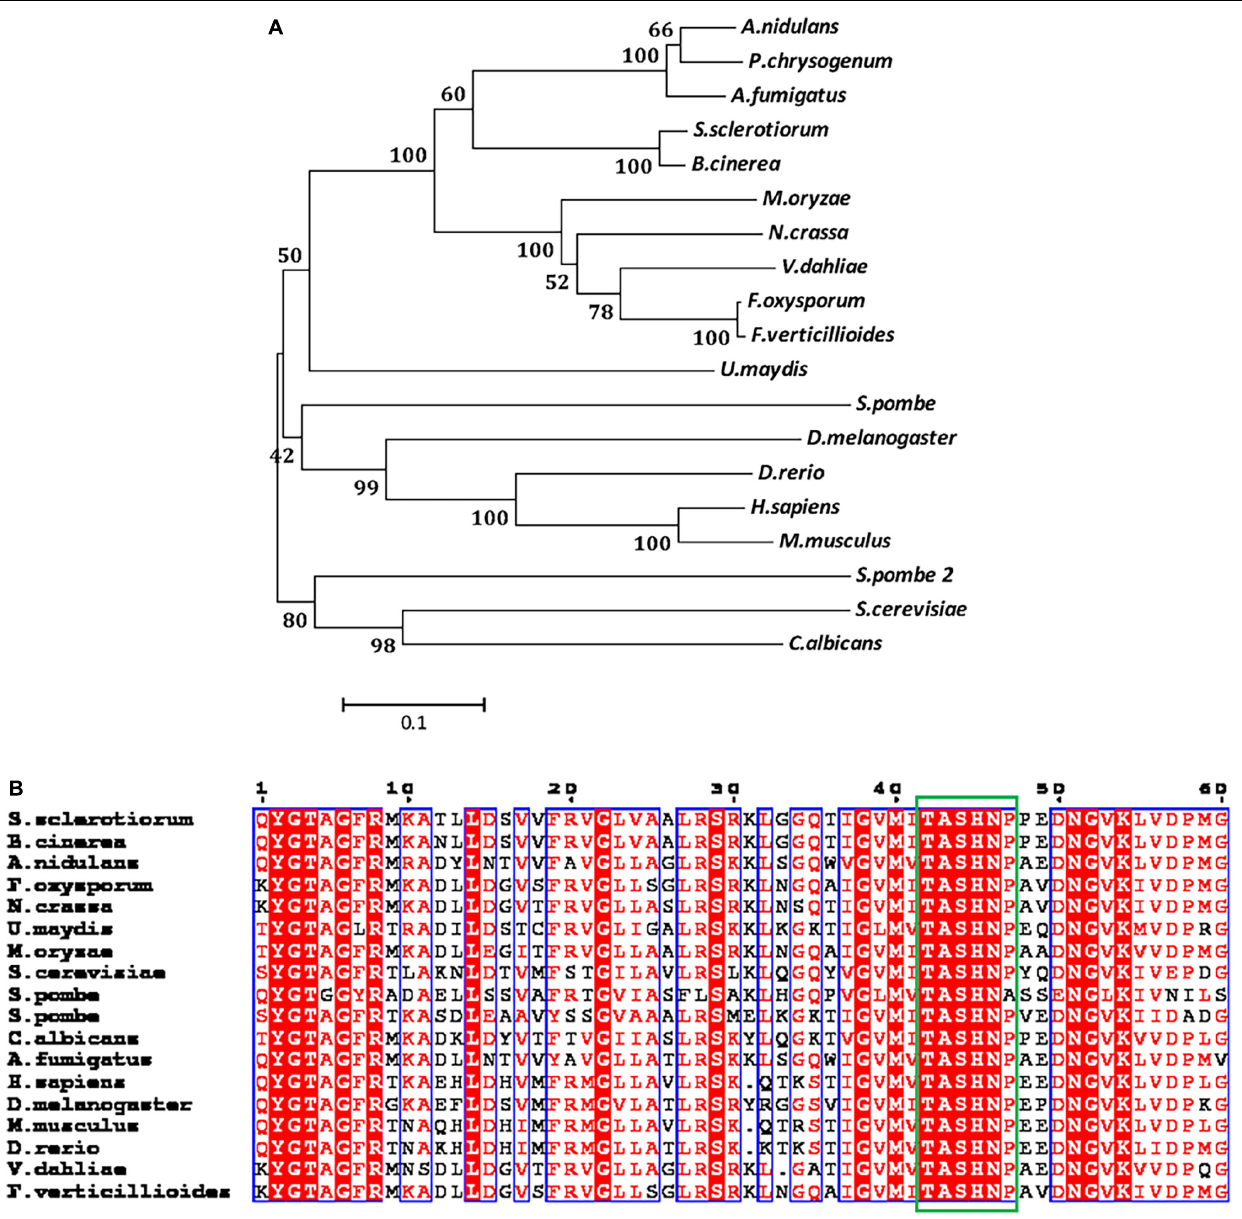
FIGURE 1 | SsAGM1 encodes an N -acetylglucosamine-phosphate mutase in Sclerotinia sclerotiorum . (A) Phylogenetic analysis of SsAGM1 and its homologs. The amino acid sequences of SsAGM1 and its homologs were aligned using ClustalW, and the phylogenetic tree was constructed using MEGA 5 with the neighbor-joining algorithm. GenBank accession numbers of S. sclerotiorum and other species are in Supplementary Table 2 . (B) Alignments of the conserved domains in SsAGM1 and its homologs. Alignments of the conserved domains by ClustalW and shown by ESPript 3.0. The conserved sequence motif Ser/Thr-X-Ser-His-Asn-Pro is shown in the green box. Residues with a score above defined threshold are written in red and boxed in